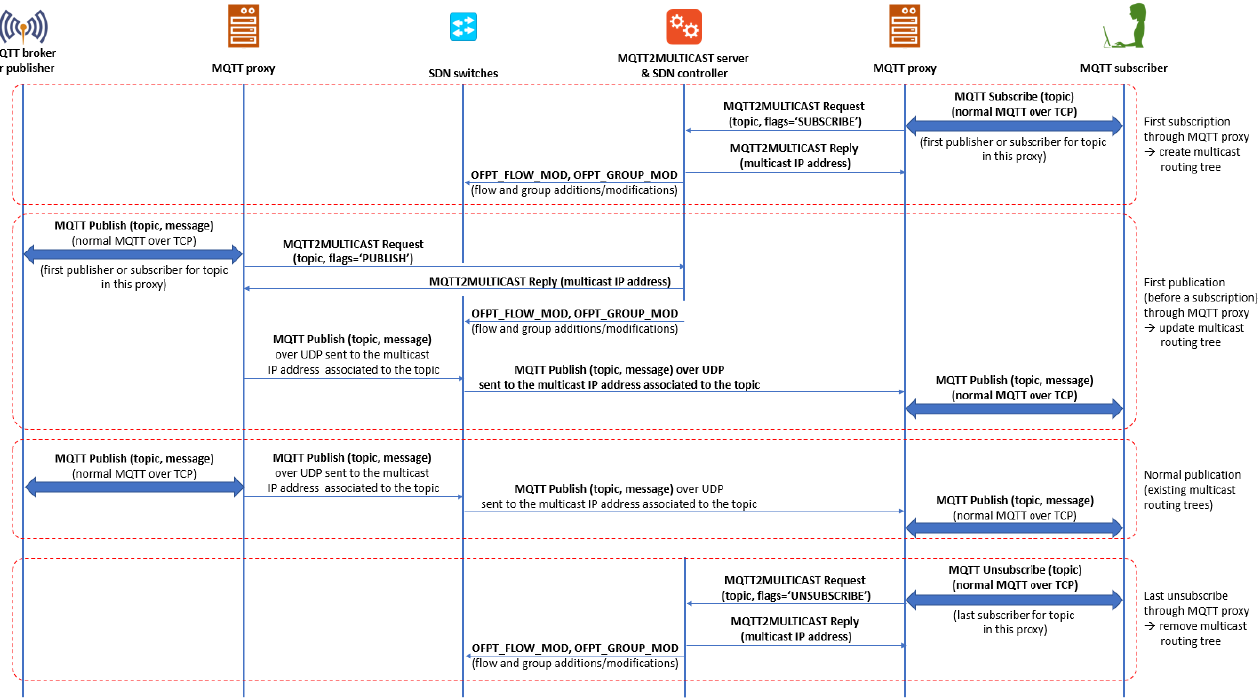
Figure 7. Message exchange between the different entities in the proposed LoRaWAN network architec-